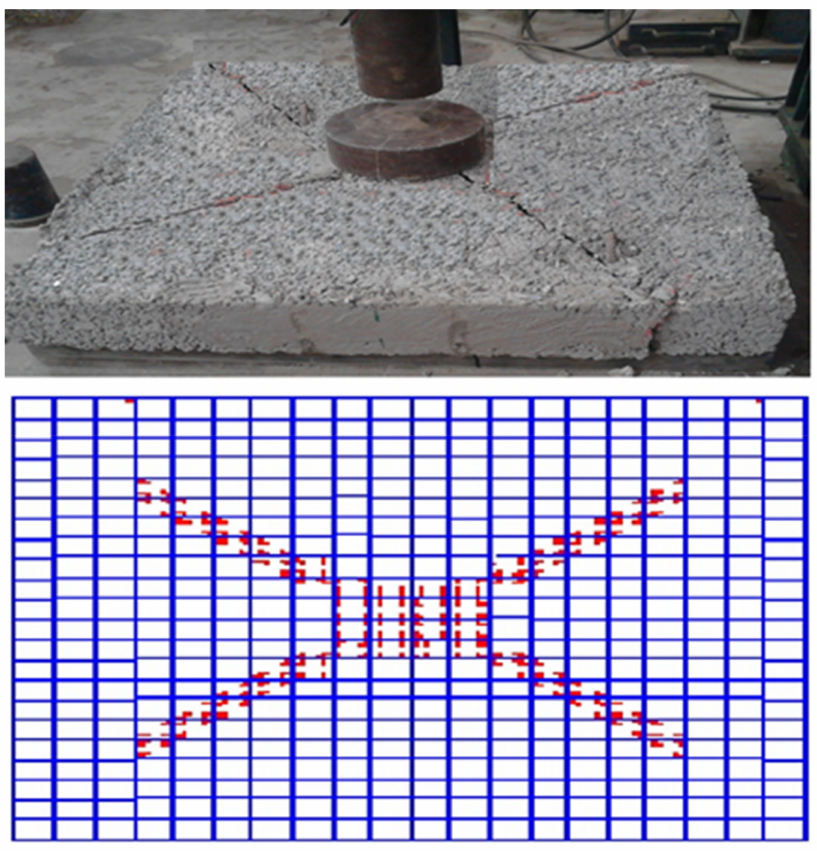
Figure 32. Crack spread for control